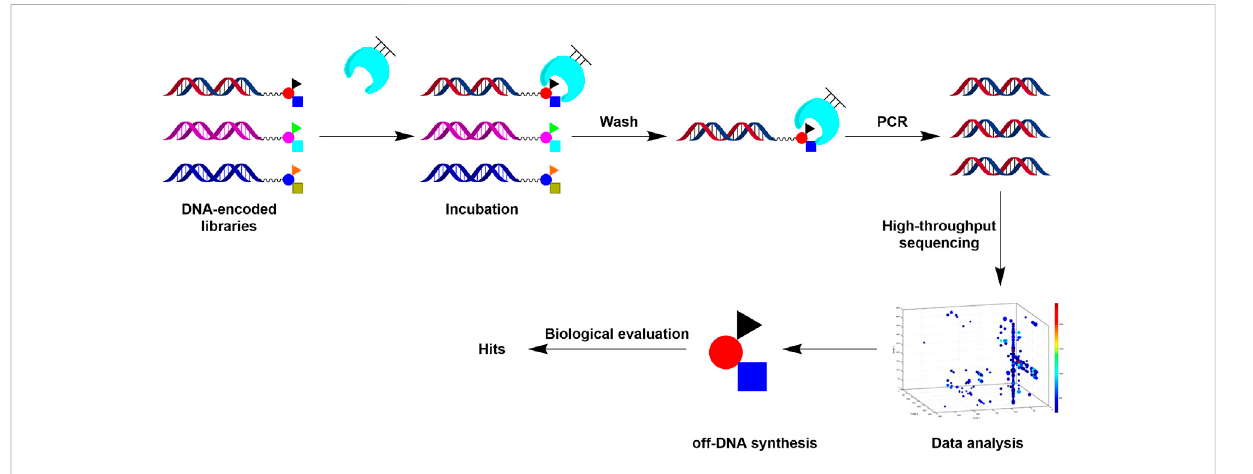
FIGURE 1 Work fl ow for DEL screening using immobilized